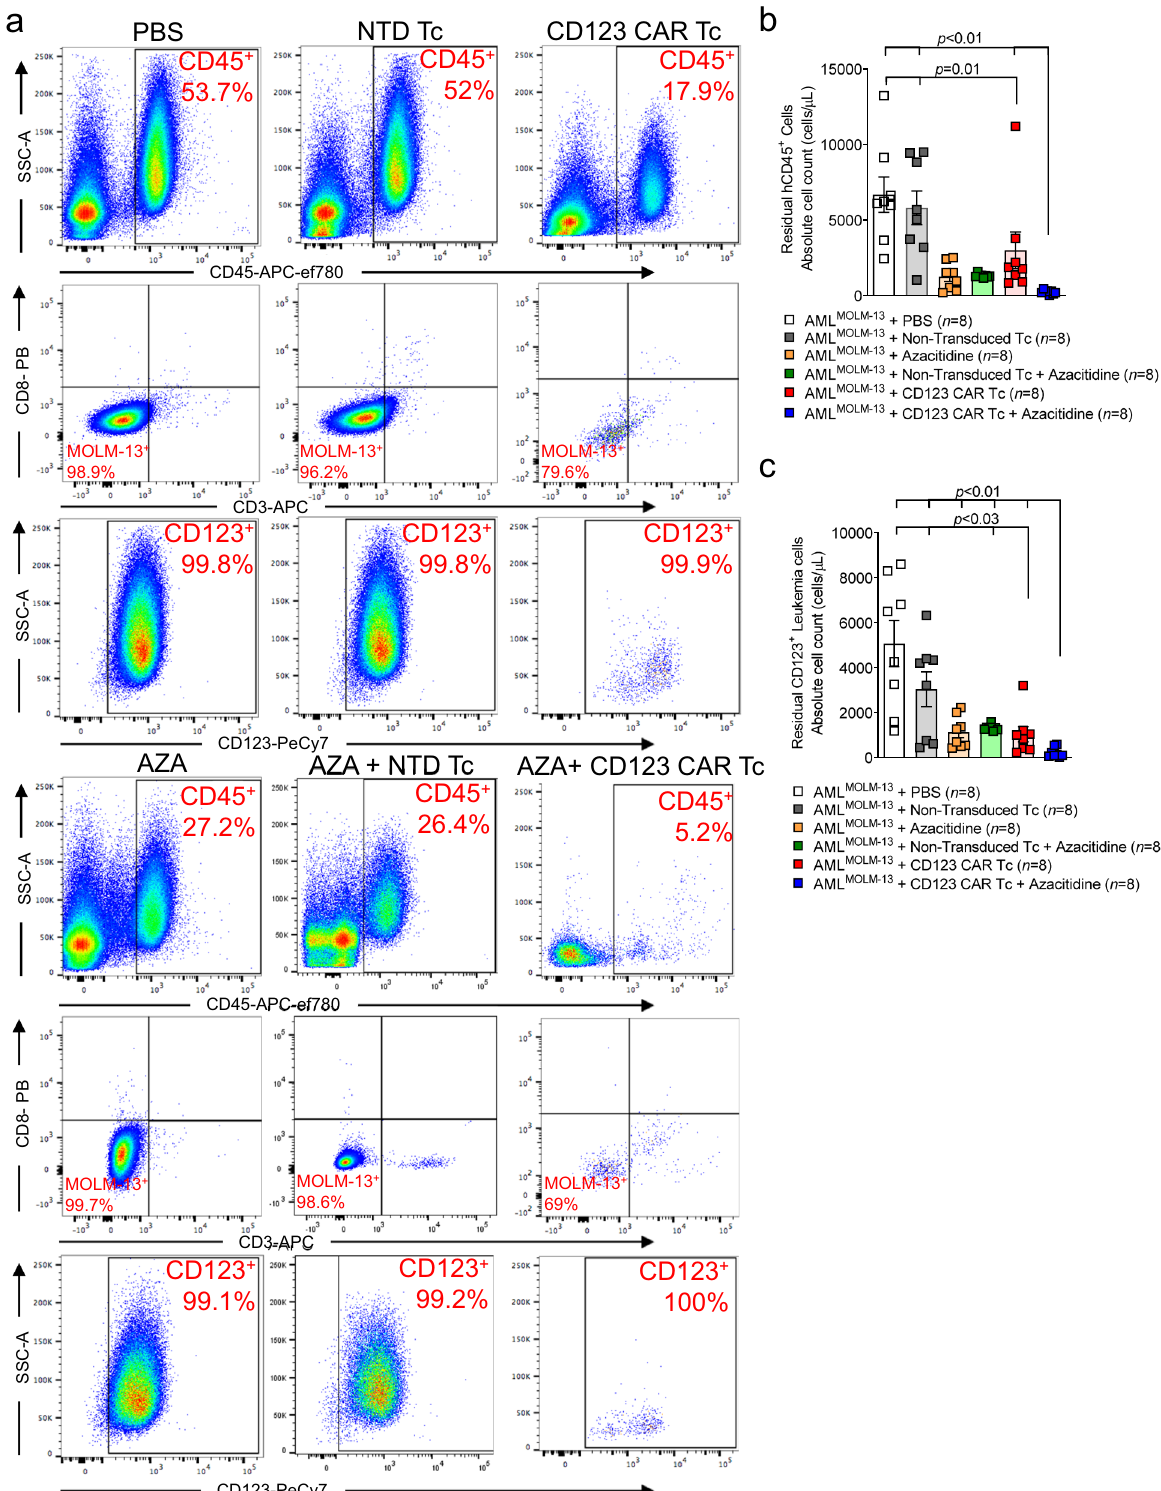
Fig. 4 Azacitidine pre-treatment enhances anti-CD123 CAR T cell-mediated AML elimination. a Representative gating strategy used for fl ow cytometry- based analysis of total human CD45 cells, residual MOLM-13 CD123 + leukemia cells as well as residual CD4 + /CD8 + T cells in the BM of mice treated with PBS, NTD Tc, anti-CD123 CAR Tc, AZA only, NTD Tc + AZA or anti-CD123 CAR Tc + AZA. Flow cytometric analysis depicting absolute cell counts (cells/ μ L) of residual b hCD45 + and c CD123 + MOLM-13 leukemia cells in the BM of the various treatment groups (PBS n = 8; NTD Tc n = 8; AZA n = 8; NTD Tc + AZA n = 8; anti-CD123 CAR Tc n = 8; anti-CD123 CAR Tc + AZA n = 8). All graphed data were pooled from two independent experiments and are represented as mean ± SEM. p- values were calculated using two-sided one-way ANOVA (Kruskal – Wallis test with Dunn ’ s multiple